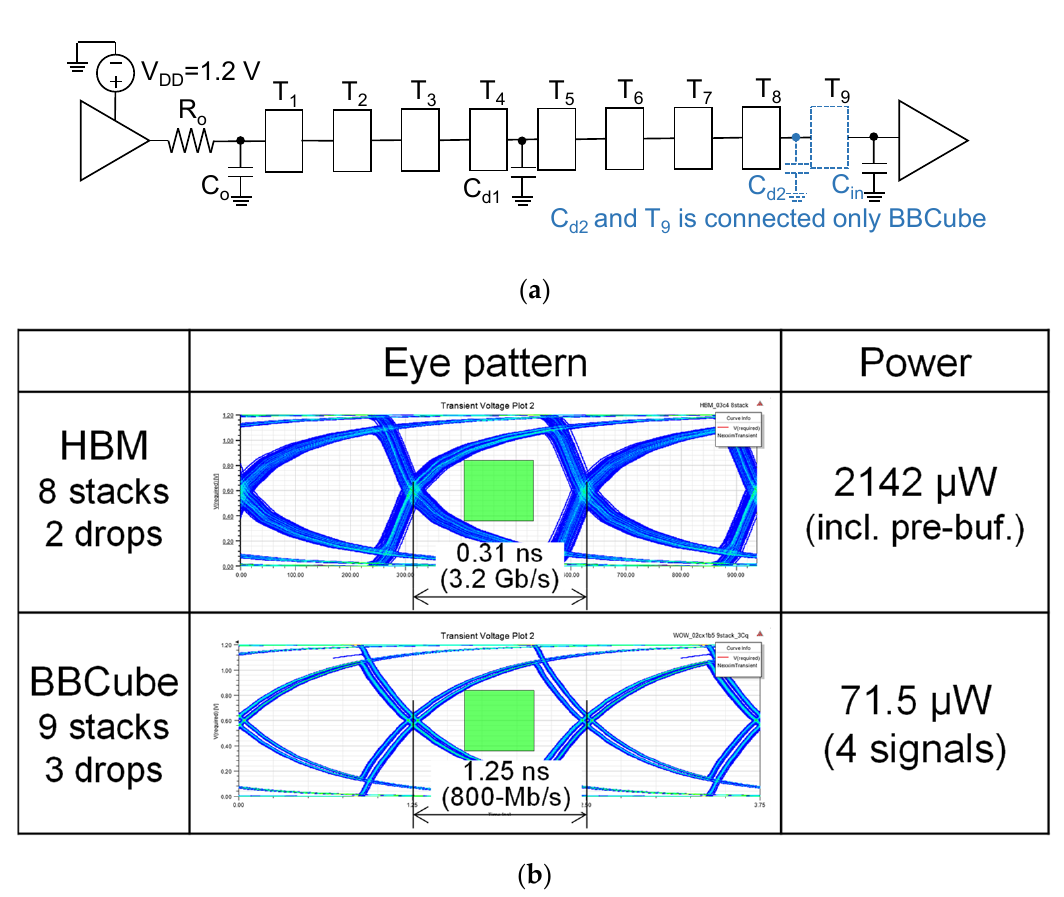
Figure 33. Eye diagram and data transfer power within a TSV: ( a ) block diagram of simulation and ( b ) comparison between HBM and BBCube.